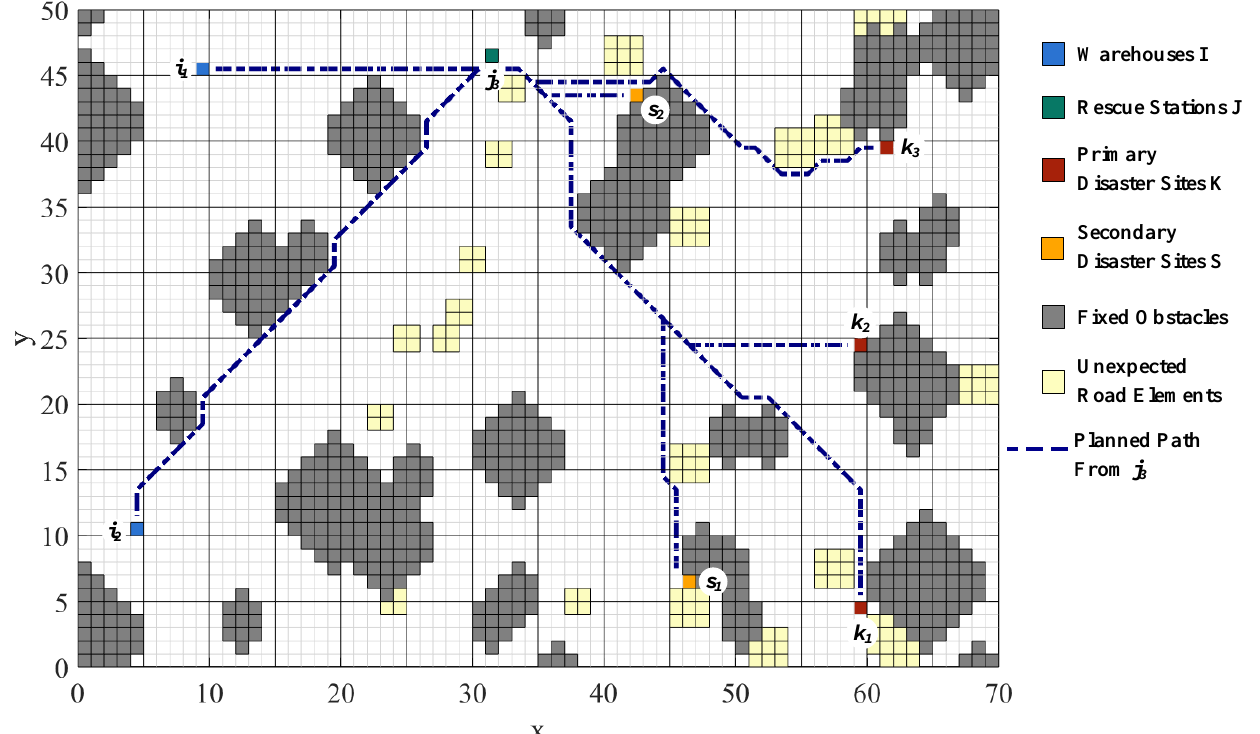
Figure 4. Paths from Rescue Station j 2 to each site.